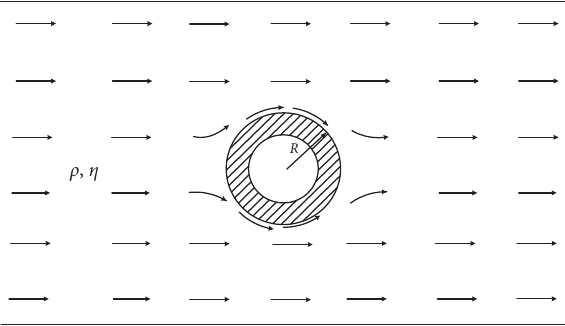
Figure 1: Schematic diagram of velocity field of the liquefaction